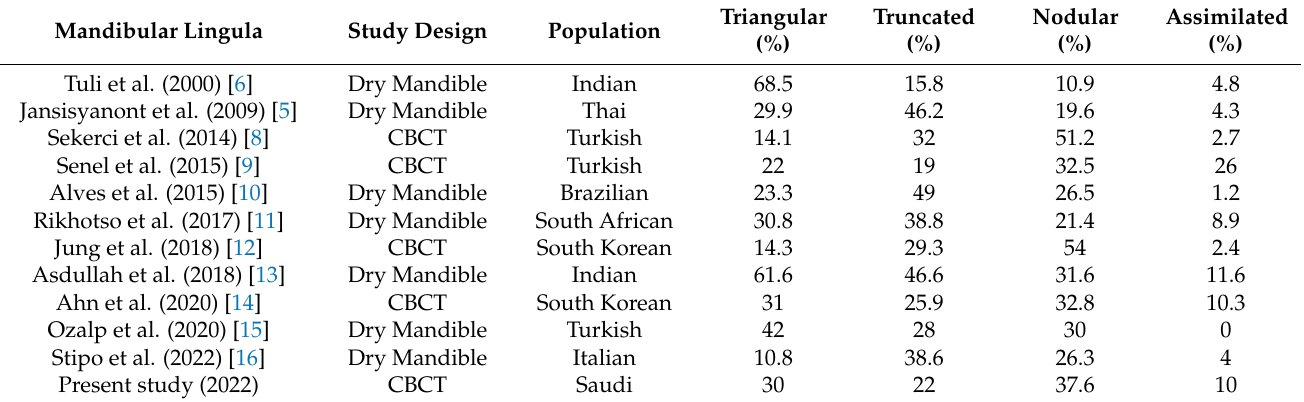
Table 6. Frequency percentage of the prevalence of lingula shapes in different